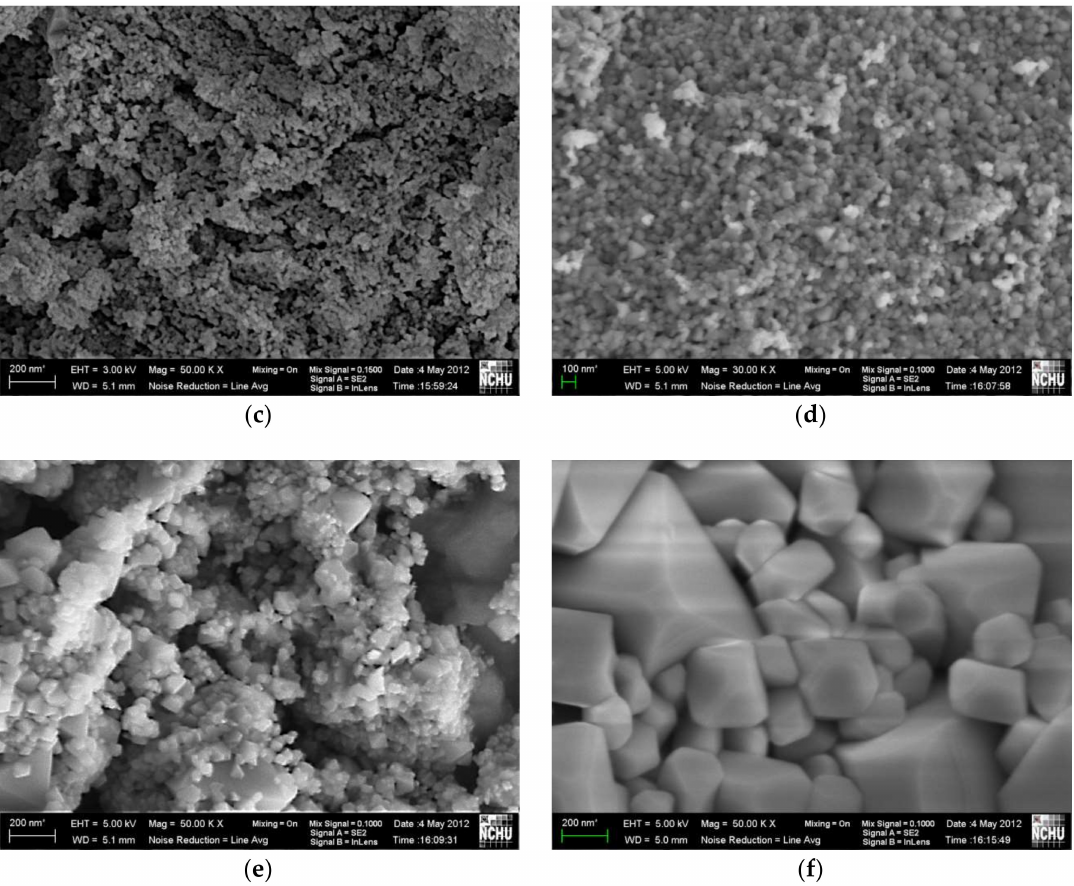
Figure 6. The surface morphologies of Cu 0.7 Zn 0.3 Fe 2 O 4 at different sintering temperatures. ( a ) Not sintered (100 KX), ( b ) 500 ◦ C, (c) 600 ◦ C, ( d ) 700 ◦ C, ( e ) 800 ◦ C, ( f ) 900 ◦